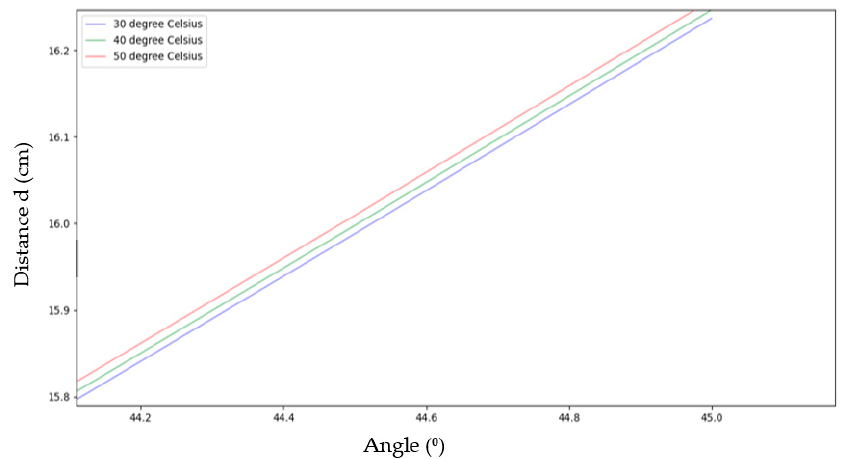
Figure 5. Effect of pure water concentration W water on the distance d for different angle of incidence θ i at λ = 660 nm and T = 30 ◦ C.